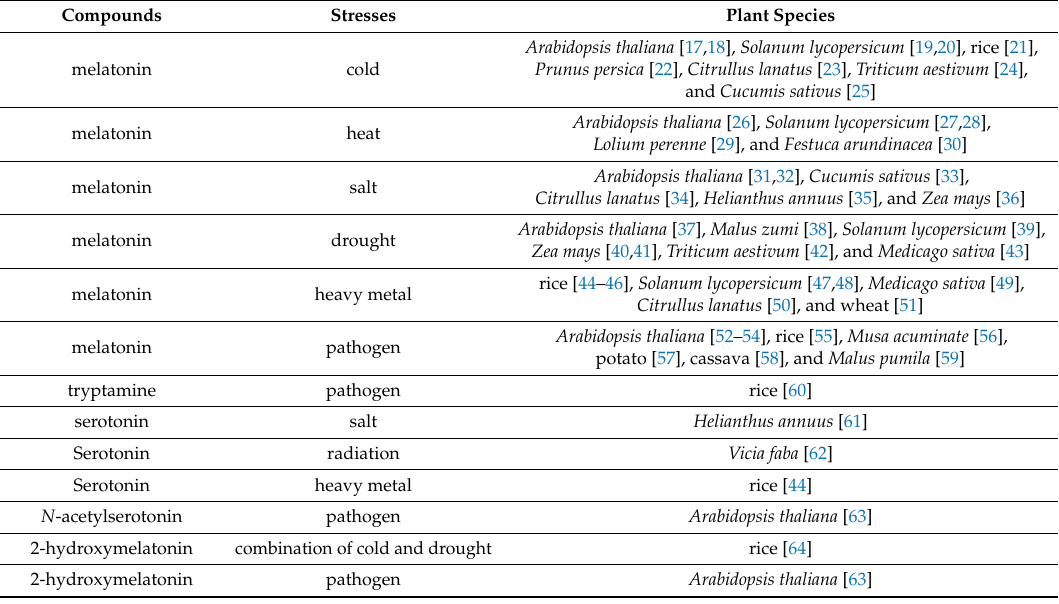
Table 1. Melatonin and its precursors and metabolites mediating plant stress